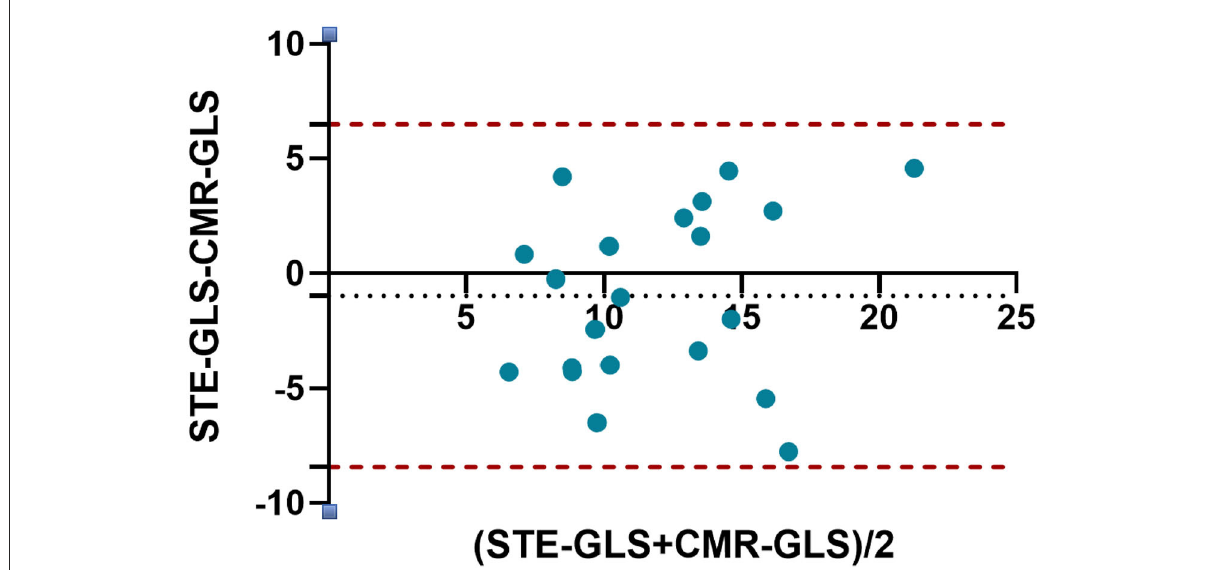
FIGURE3 Bland-Altman plot for agreement between RVGLS obtained by 2D-STE and CMR-FT. The horizontal dots represent the mean difference, and the dashed lines represent ± 2 standard deviations of the